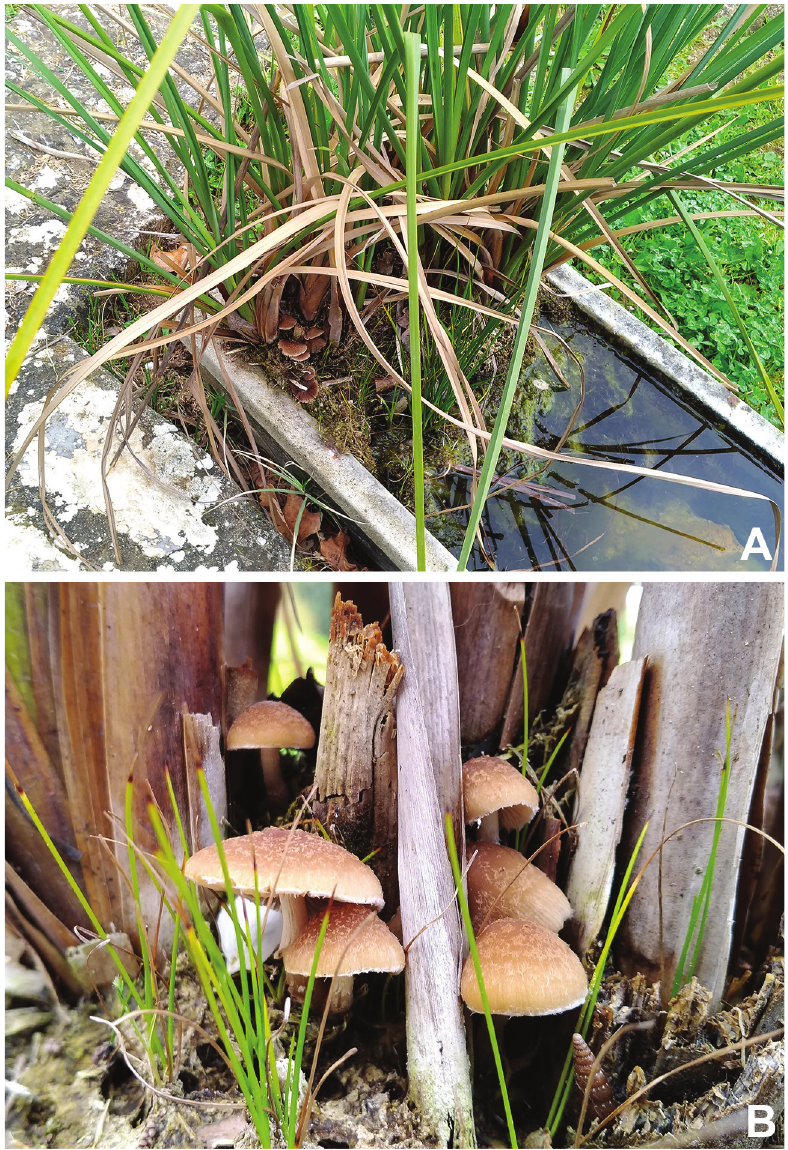
Figure 1. A tuft of Cladium mariscus planted in a tank at the Botanical Garden of the University of Calabria, southern Italy ( A ), and first-sight features of Psathyrella basidiomes at the base and in-between of remnants of excised culms of the plant ( B